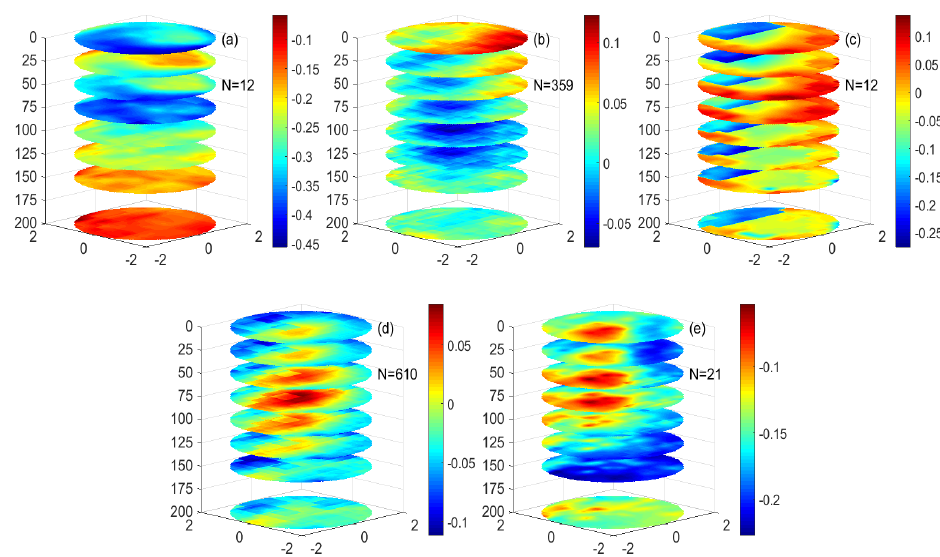
Figure 13. The three − dimensional structure of salinity anomalies of the different eddies. ( a – e ) are ( a ) mode-water eddies, ( b ) low nonlinear anticyclonic eddies, ( c ) high nonlinear anticyclonic eddies, ( d ) low nonlinear cyclonic eddies, and ( e ) high nonlinear cyclonic eddies. (Unit: PSU).